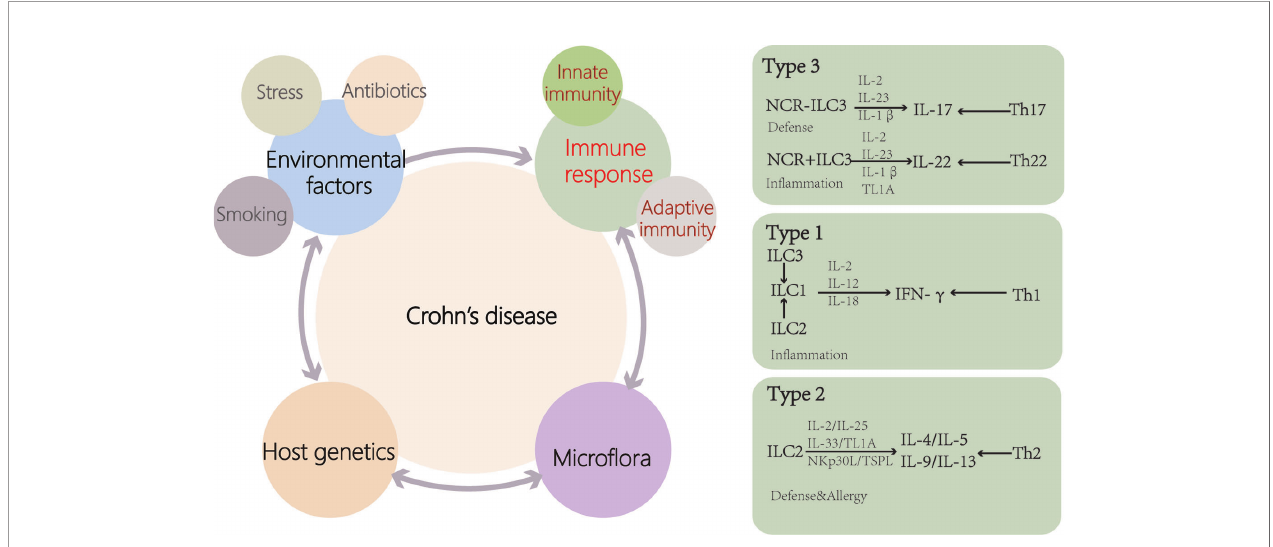
FIGURE 2 | Causes of Crohn ’ s disease (CD). Genetic susceptibility is one of the important causes of CD patients. Disturbances of the micro fl ora and environmental factors can cause abnormal immune responses, including innate and adaptive immunity, leading to intestinal in fl ammation. Disease outbreaks are related to environmental factors such as antibiotic use, stress and smoking. ILCs are activated by cytokines and cell surface-bound molecules to produce distinct sets of cytokines with important consequences for tissue homeostasis and disease. ILCs display a high degree of plasticity and can trans-differentiate depending on the in fl ammatory environment (TL1A, TNF-like ligand